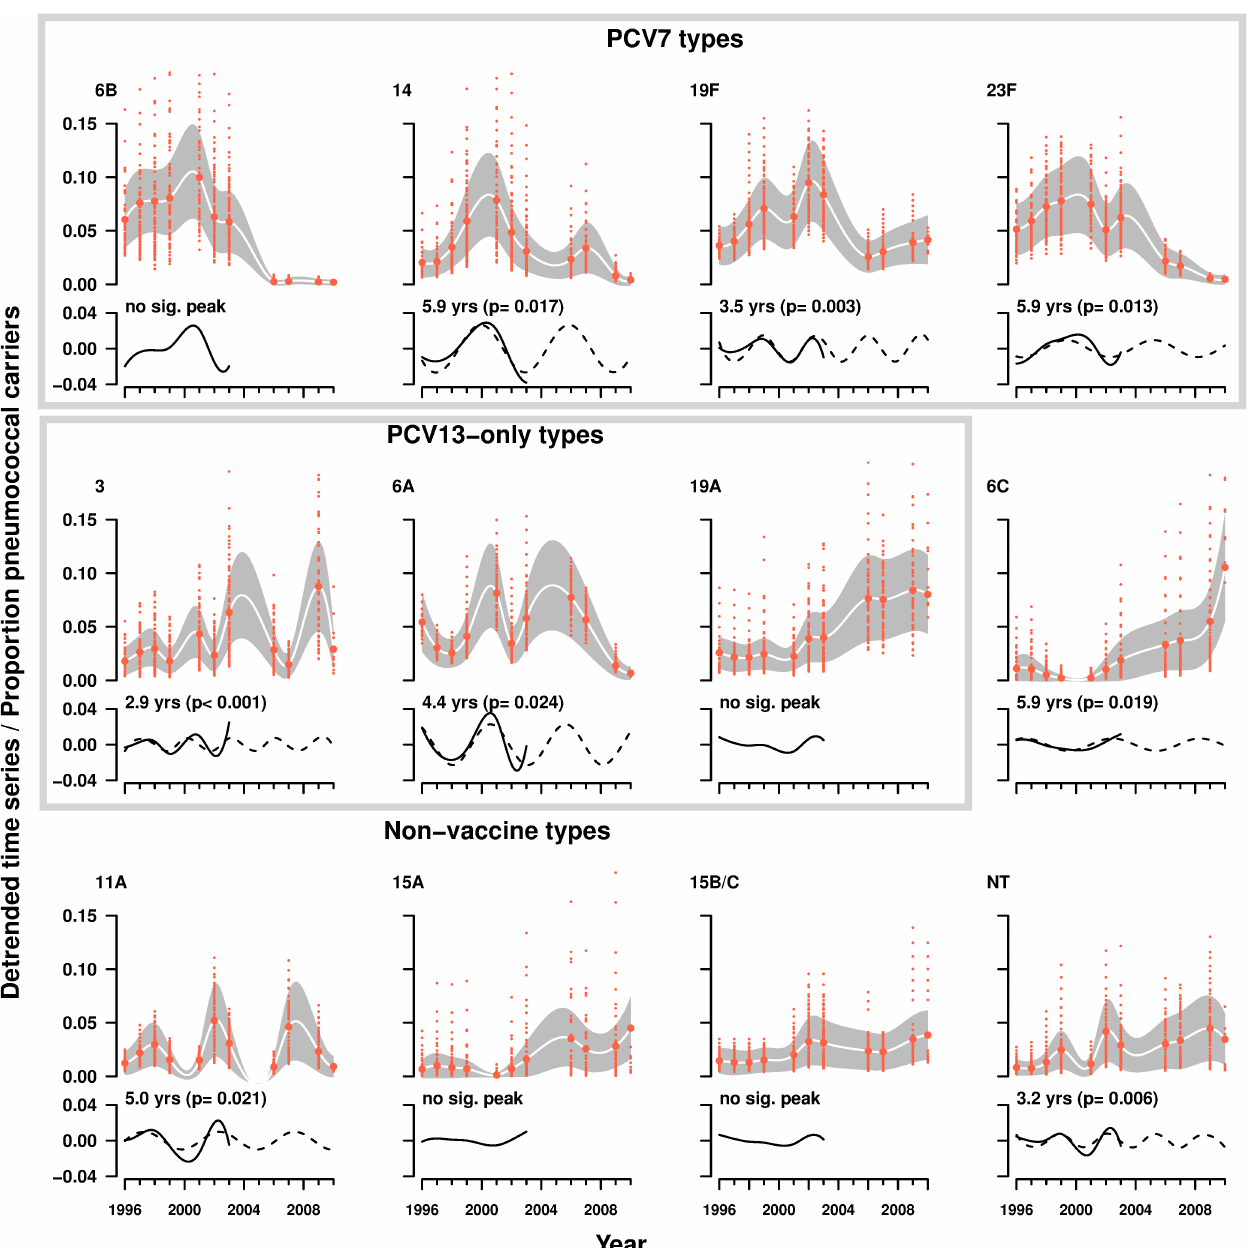
Fig 1. Proportion of carriersaccording to pneumococcal serotype as a function of time. Panels show the fit (white line) of a mixed generalizedadditive model to the proportionof carriers of specific serotypes per year, and the correspondingharmonic periodestimated from the detrendedtime series from 1996to 2003. For the detectionof significantharmonic peaks we used 7 tappers and a time-bandwidth of 0.56. Large red dots, indicatemean proportionof carriers by year. Small red dots indicatethe proportionof carriers by day-carecenter and child age. The gray shaded area representsthe confidenceinterval at 95% estimated from the fit of the model. In the detrendedtime-series the solid line represents the expectedcycle whereasthe dashedlines representsthe cycle observedfor the pre- and low-PCV7 periods.” the cyclic pattern predicted by the model (Fig 1). For NT strains, in the high-vaccine period, a single peak was observed instead of the two peaks forecasted by the model.